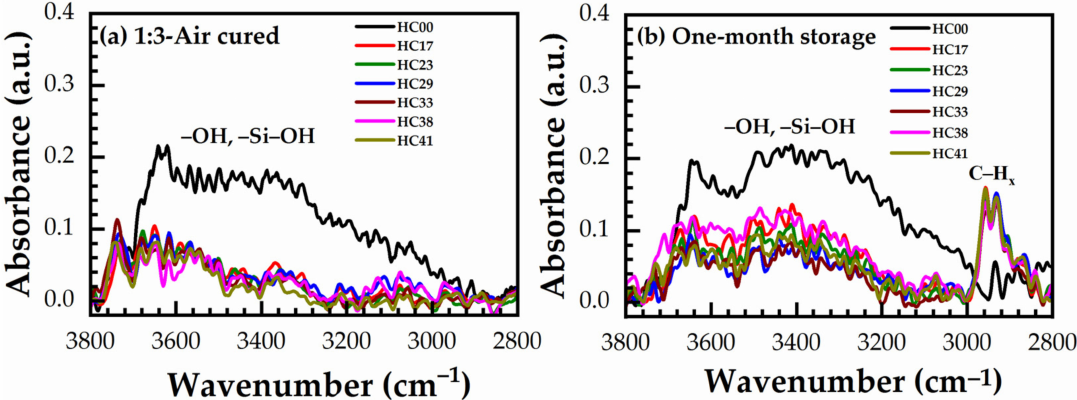
Figure 17. Fingerprint region of FTIR spectra of ( a ) air cured for 30 min (just cured) and the corresponding ( b ) one-month stored samples with different porogen (0 to 41 wt%, films numbered from HC17 to HC41) loadings.